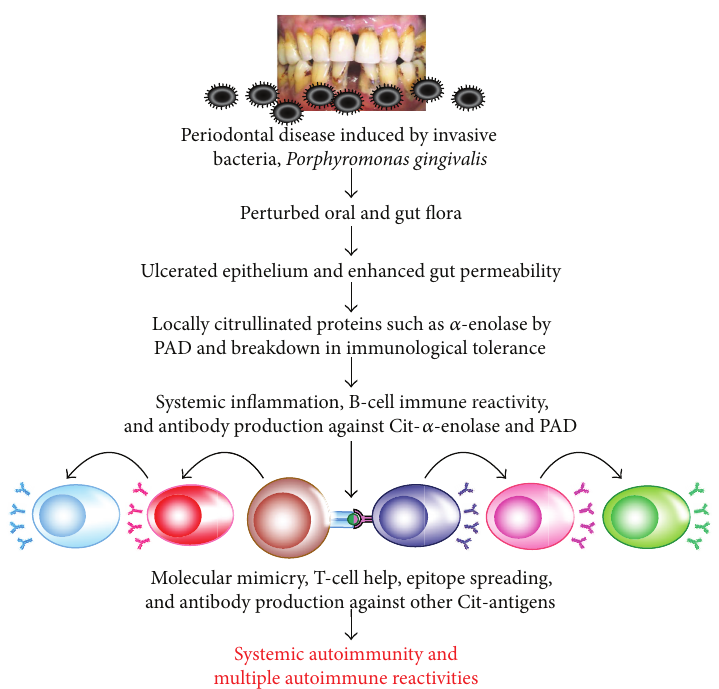
Figure 15: Proposed model for the pathogenesis of multiple autoimmune reactivities by infection. Bacterial generation of autoantigens, local inflammation generating autoantigens by PAD, antibody production against one autoantigen, epitope spreading, antibody production against multiple antigens, systemic inflammation, and multiple autoimmune